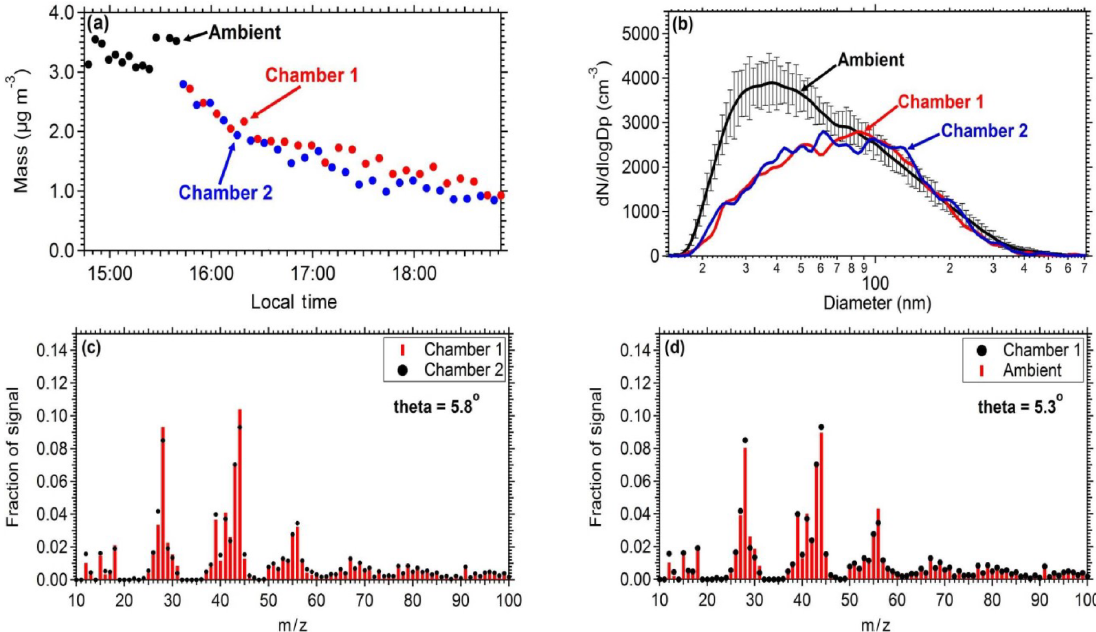
Figure 3. Comparison of the measurements between the two chambers and between ambient measurements: (a) mass concentration (PM 0 . 7 ) as measured by the SMPS in both the chambers and the ambient air. (b) Number distributions inside the chambers and in the ambient air (the error bar represents 1 standard deviation). (c) Average aerosol mass spectra of chamber 1 and chamber 2 filled with ambient air. (d) Average aerosol mass spectra of ambient air and chamber